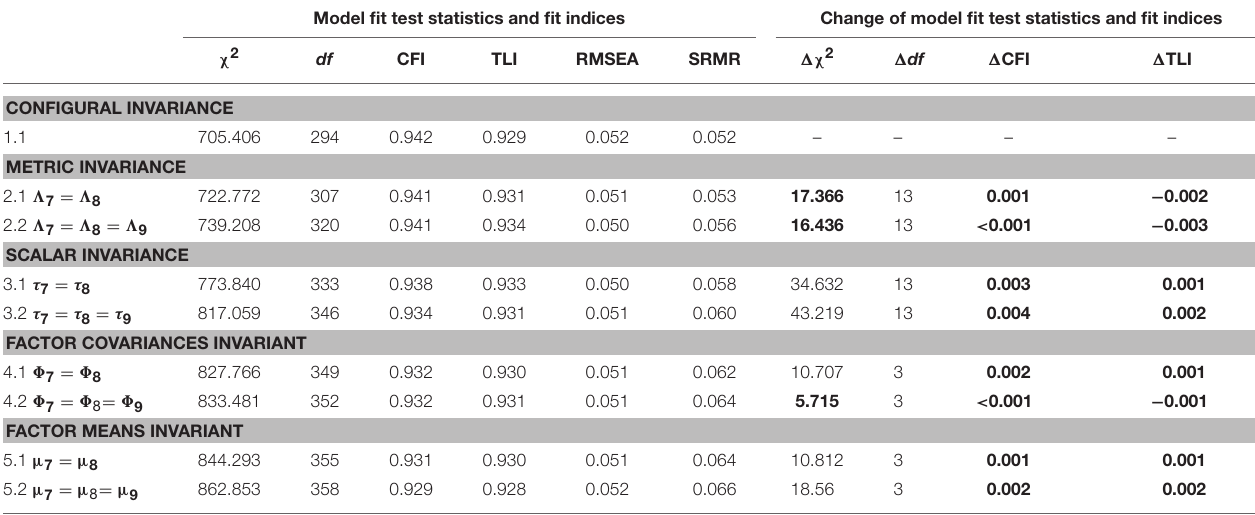
TABLE 6 | Model fit test statistics, fit indices, and their changes for the longitudinal MI analyses of years 7, 8, and